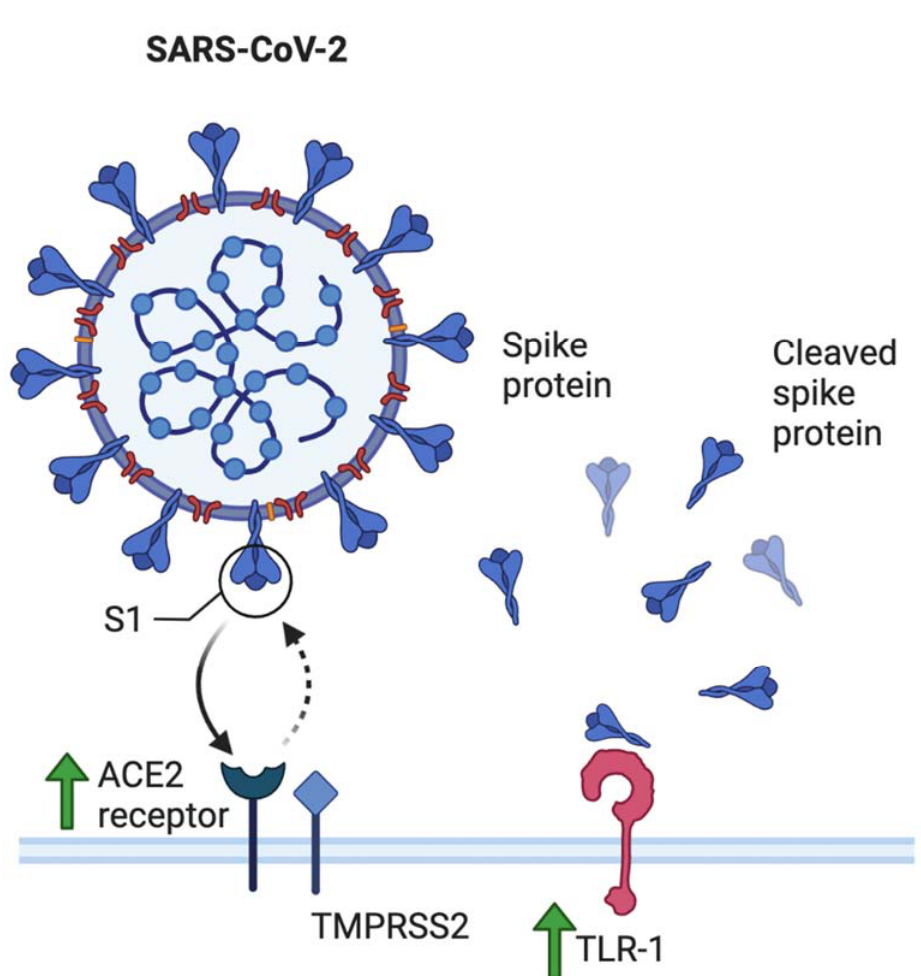
Figure 3. ACE2 and TLR-1 are known to bind to SARS-CoV-2 spike protein S1 and are increased in maternal circulation, leading to increased susceptibility of pregnant women to SARS-CoV-2 infection through increased viral binding and subsequent fusion into host cell.